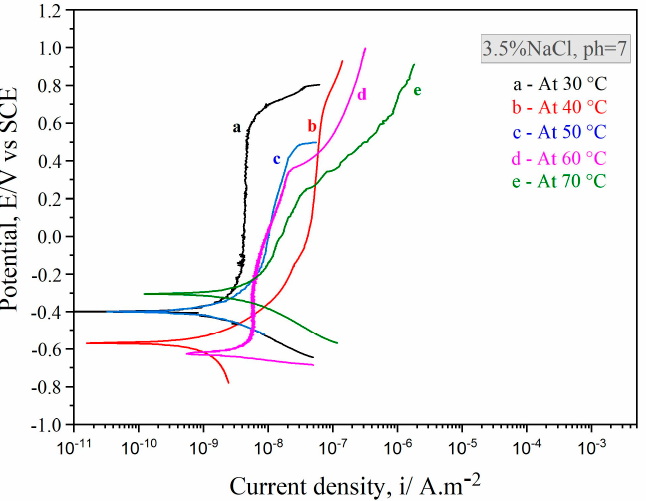
Figure 3. Potentiodynamic polarization curves of the Fe 49.7 Cr 1.8 Mn 1.9 Mo 7.4 W 1.6 B 15.2 C 3.8 Si 2.4 coatings deposited under the conditions of 30 °C, 40 °C, 50 °C, 60 °C, and 70 °C in 3.5% NaCl solution.